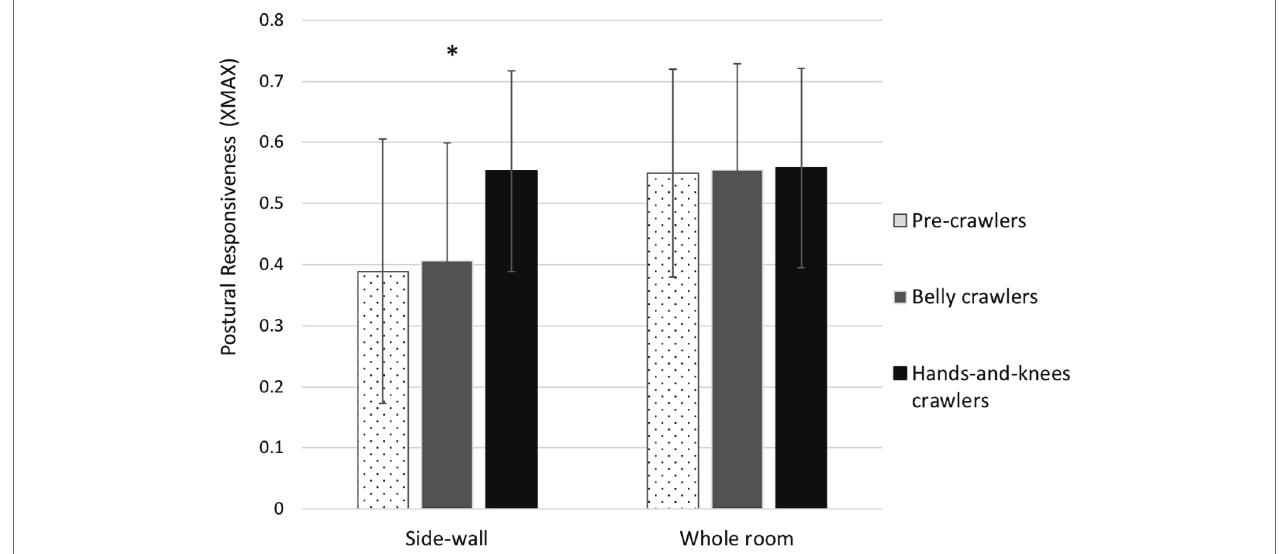
FIGURE 1 | Infant postural responsiveness (XMAX) in the whole-room forward movement condition (global optic flow) and side-wall forward movement condition (peripheral lamellar optic flow). Error bar indicates +/− standard error from group means. *indicates p <